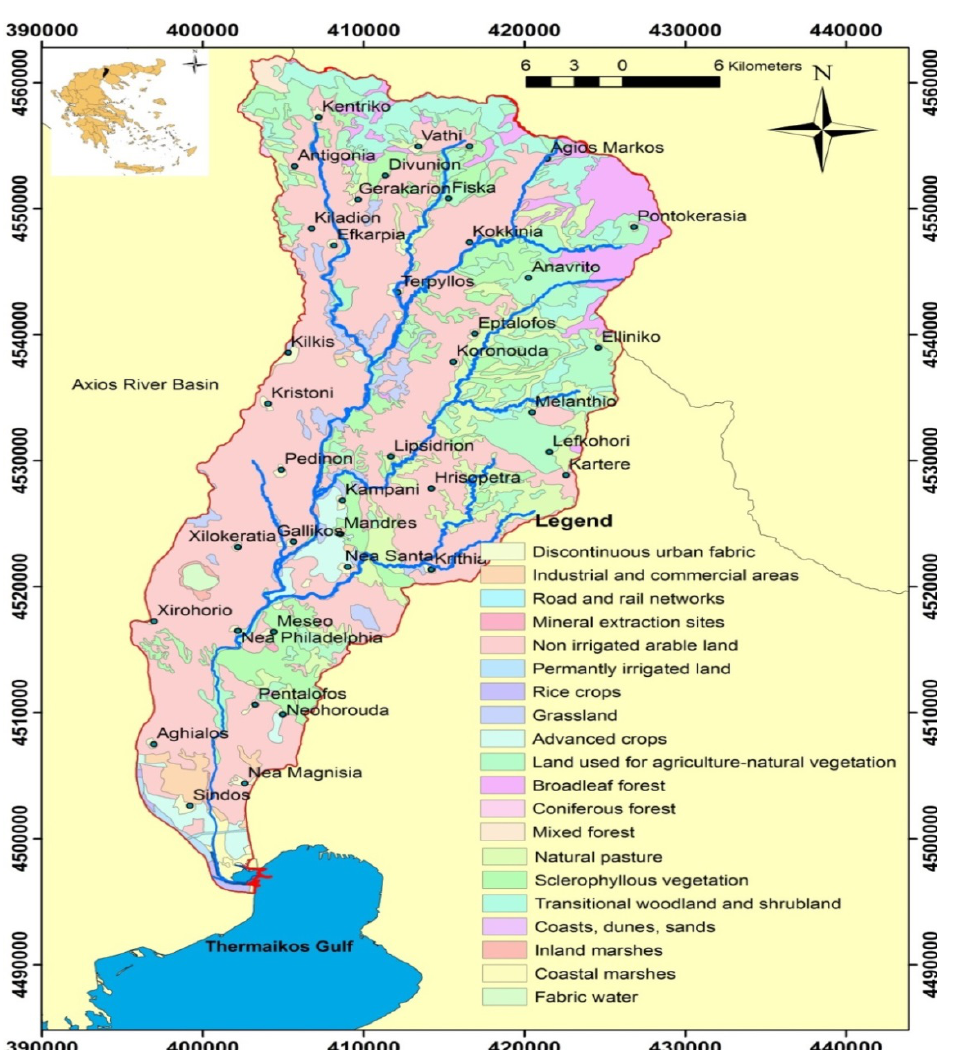
Figure 3. Land cover in the Gallikos River basin (illustrated by the authors, based on available online digital archives